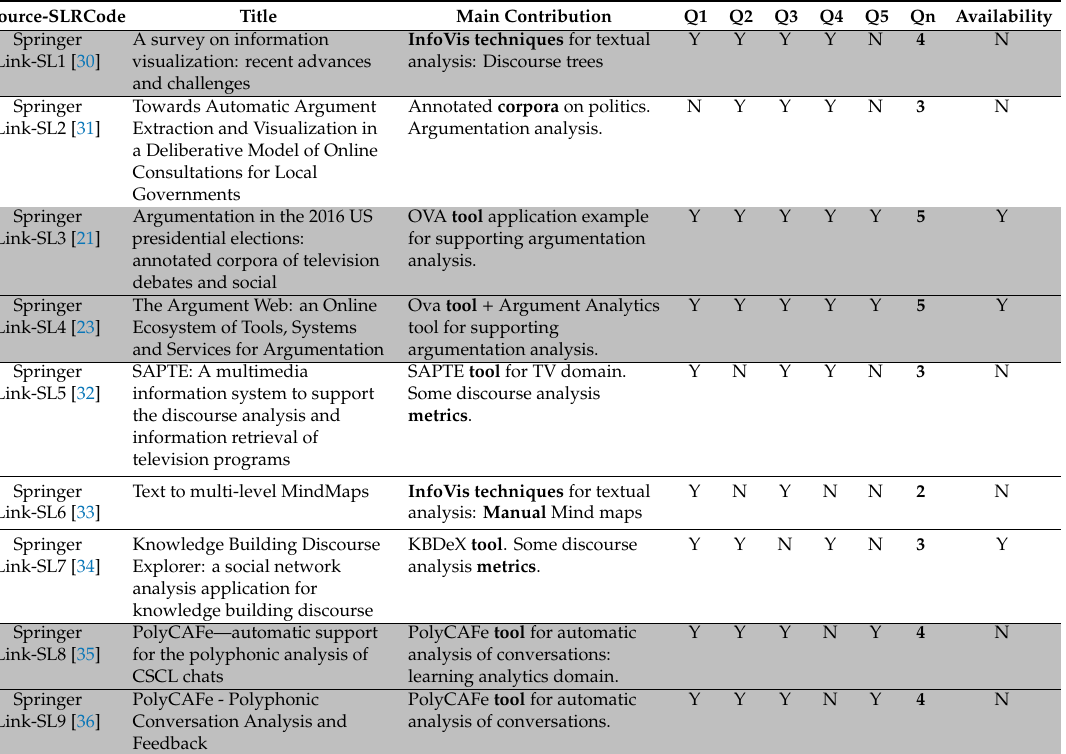
Table A1. Quality assessment SLR phase results, evaluating 59 publications (58 publications eliminating replications) from 7 di ff erent source repositories. Gray marked rows constitute publications included in the final SLR repository (17 publications). “Main contribution” column shows in bold the kind of software support contribution according to our seven categories (defined in RQ2) for each